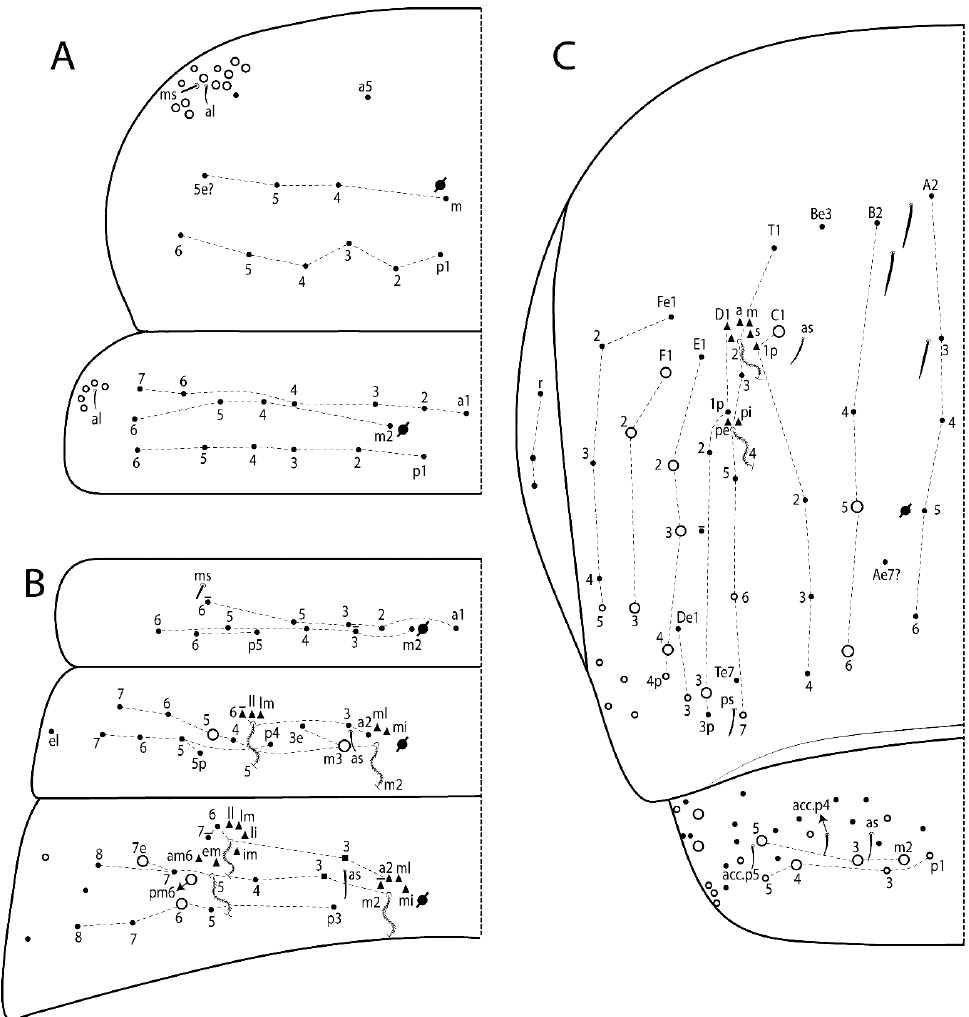
Figure 38. Pseudosinella alfanjeunguiculata sp. nov.: dorsal chaetotaxy. ( A ) Th II–III; ( B ) Abd I–III; ( C ) Abd IV–V.